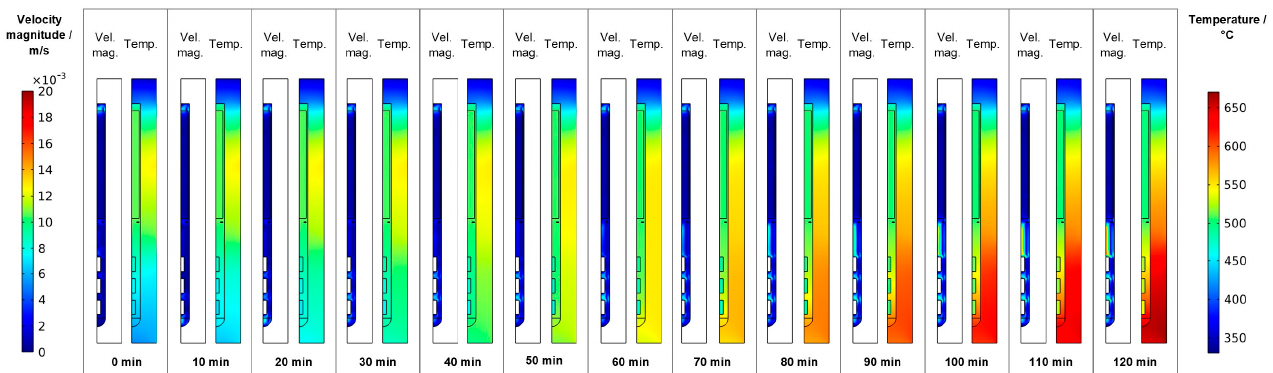
Figure 8. Velocity magnitude and temperature fields occurring during set temperature change for temperature inversion (0 min: quasi-stable etch-back condition, 120 min: reaching of growth stage set temperatures).